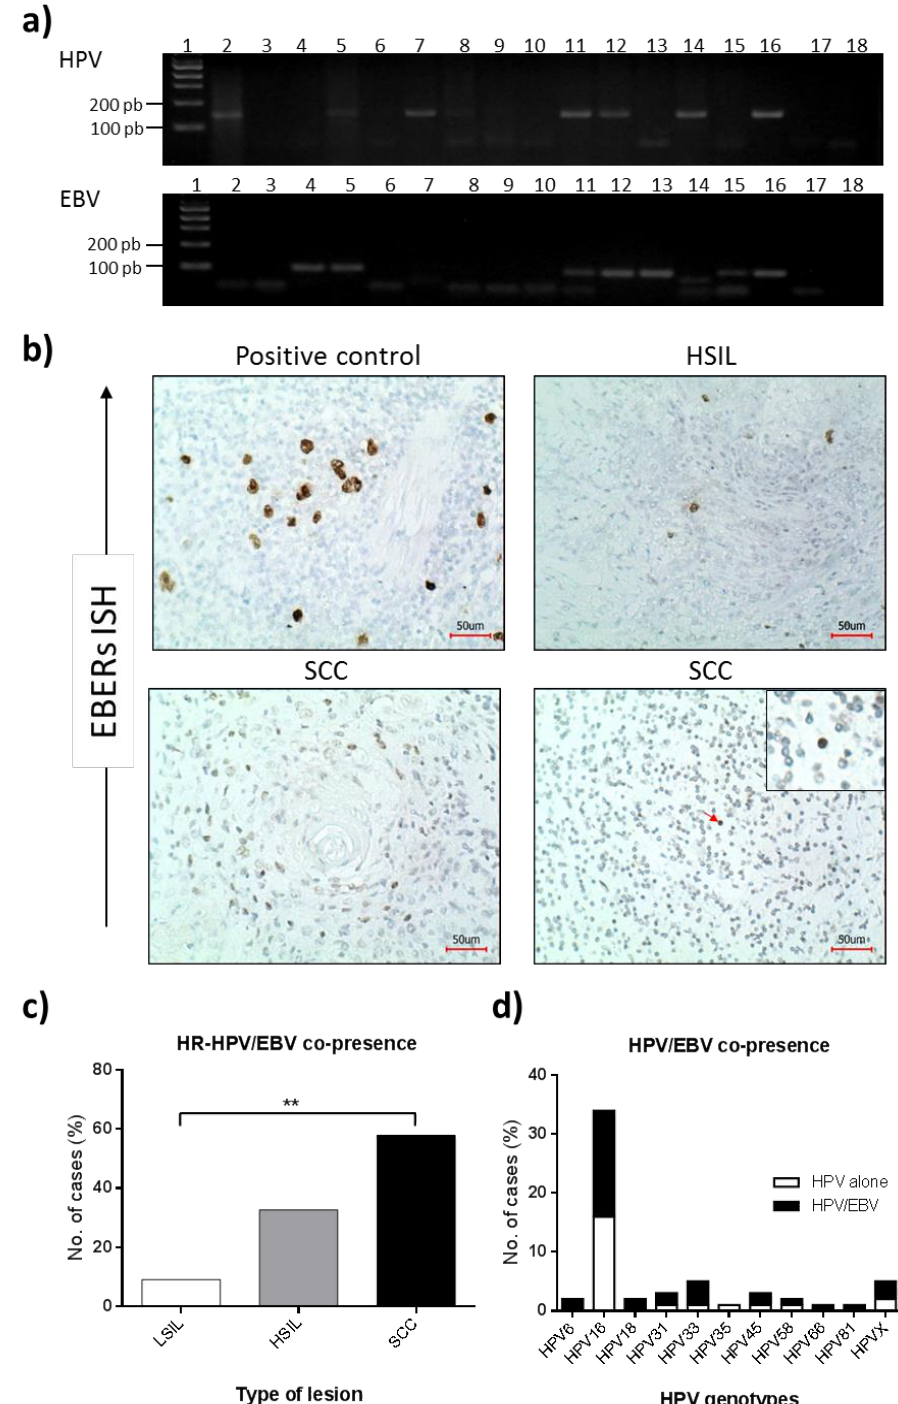
Figure 1. HPV and EBV infection in cervical lesions. ( a ) Conventional PCR for HPV (upper panel) and EBV (lower panel). Lane 1: 100-pb DNA ladder, Lanes 2–15: cervical samples, Lane 16: positive control (HeLa cells), Lanes 17 and 18: negative controls (extraction buffer or nuclease-free water). ( b ) In situ hybridization for EBERs in cervical lesions. A Hodgkin’s lymphoma sample was used as positive control. A positive signal for EBERs (brown color) is observed in a HSIL and a cervical SCC sample, located in epithelial cells and tumor-infiltrating lymphocytes (red arrow). Samples were counterstained with Hematoxylin (blue color). Red bar = 50 µ m. ( c ) HR-HPV/EBV co-presence was increased in cervical SCC when compared to LSIL (** p = 0.008). ( d ) Distribution of HPV/EBV co-presence according to HPV genotype.